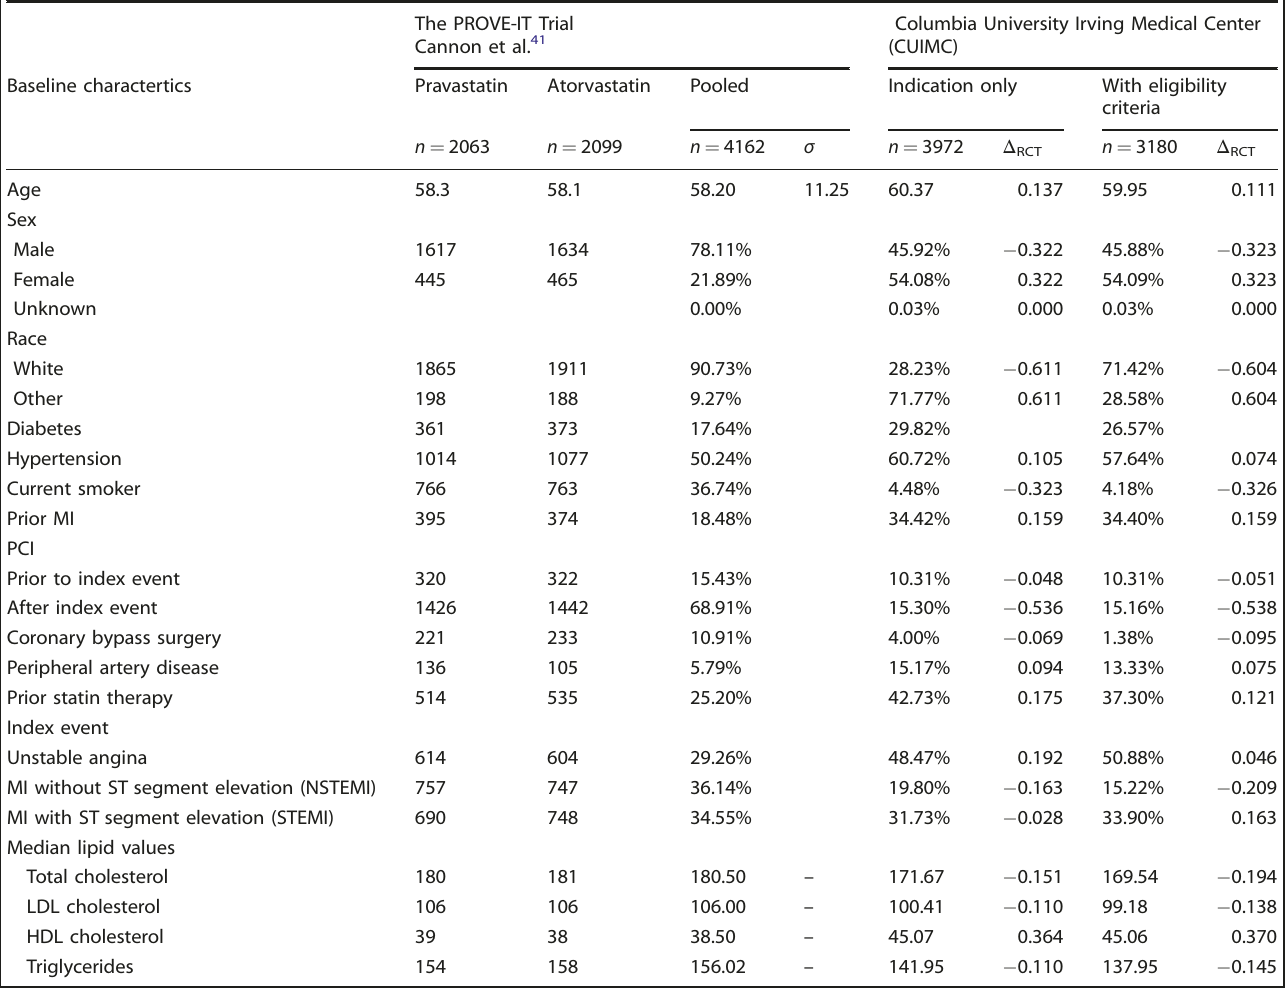
Table 2. Results for atorvastatin vs. pravastatin trial (PROVE-IT).